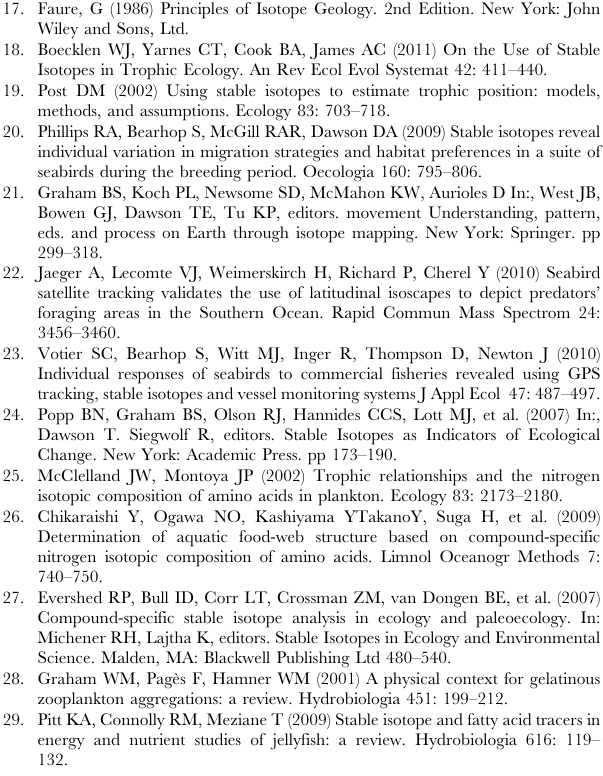
Table S1 Summary of satellite transmitter deployments and body size information for leatherback turtles nesting at Jamursba-